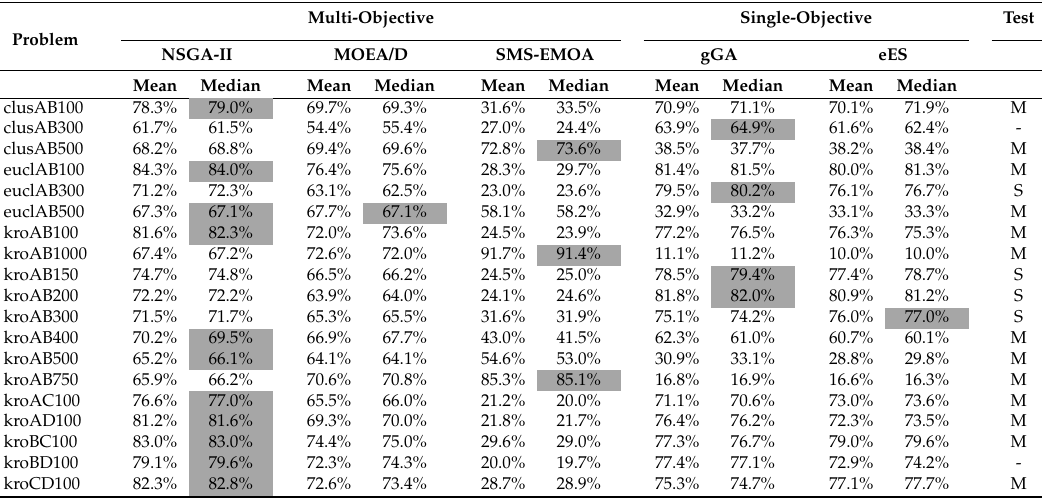
Table 8. Results for TSP instances (objective